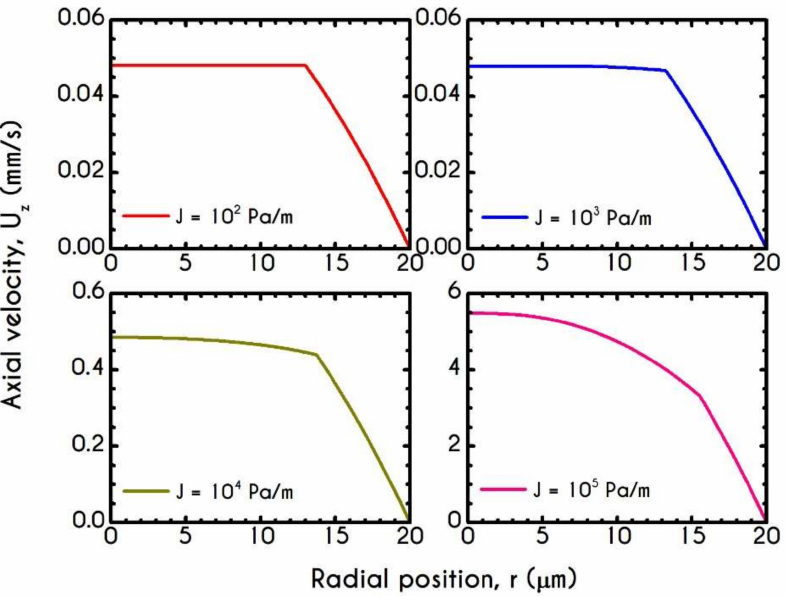
Figure 15. Axial velocity profile along the radial position for pressure gradient J equal to 10 2 Pa/m, 10 3 Pa/m, 10 4 Pa/m, and 10 5 Pa/m for R = 20 µ m and H c =